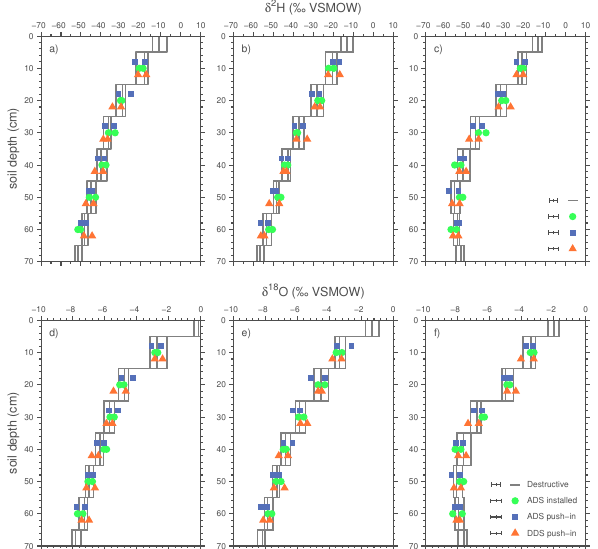
Figure 4. Depth profiles of pore water δ 2 H l and δ 18 O l for a bare soil (a, d) , grass (b, e) , and beech (c, f) plot obtained based on in situ (vertically shifted for visibility) and destructive sampling. The methodological accuracy associated with each symbol is indicated in terms of 95% limits of